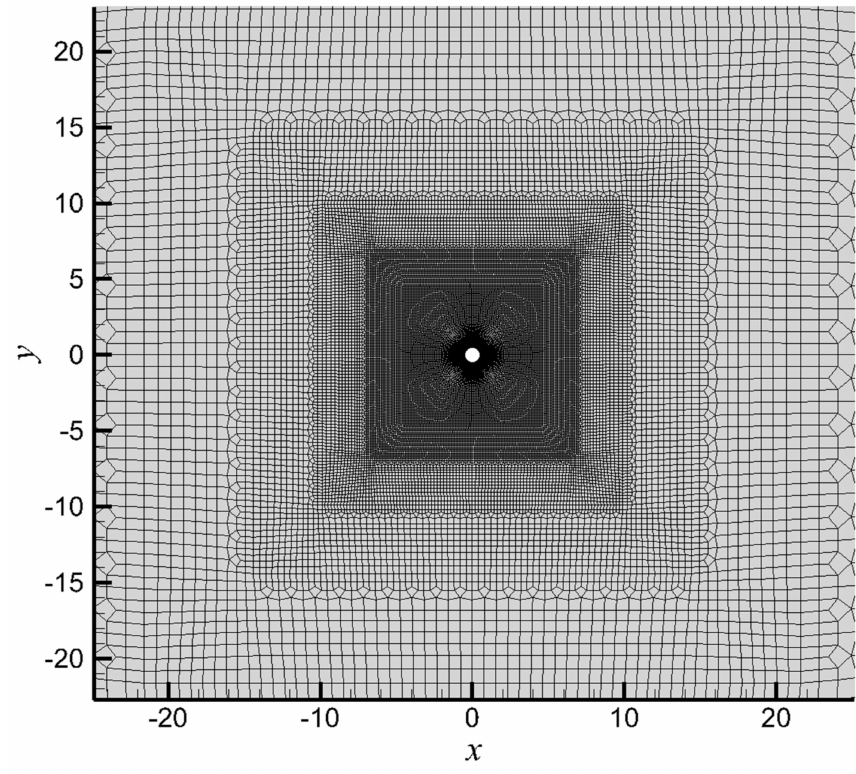
Figure 2. Computational mesh around the cylinder (the total dimensionless domain size is 110 ×